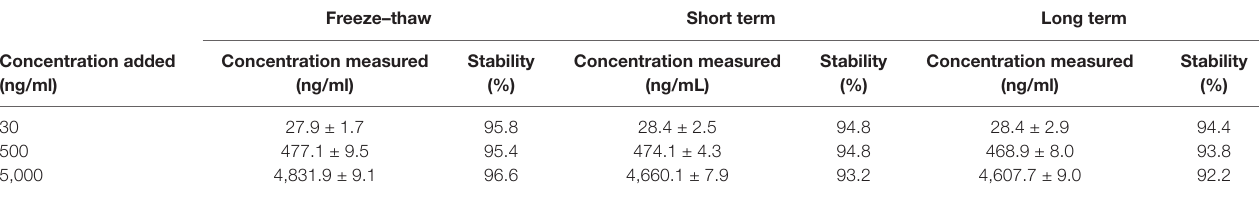
TABLE 4 | Stability of mogroside V in rat plasma (n =